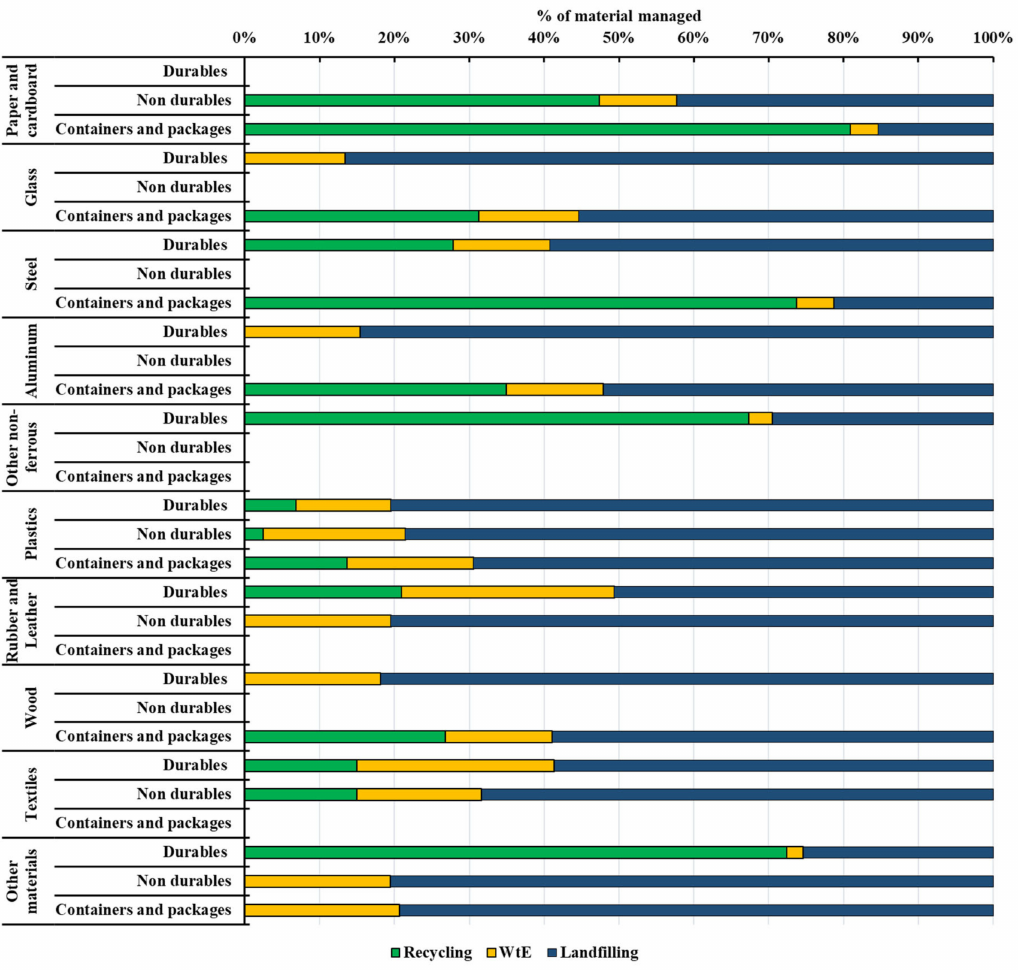
Figure 3. Management of materials contained in broad categories assessed, in 2018. Other non-ferrous contain mainly lead from lead-acid